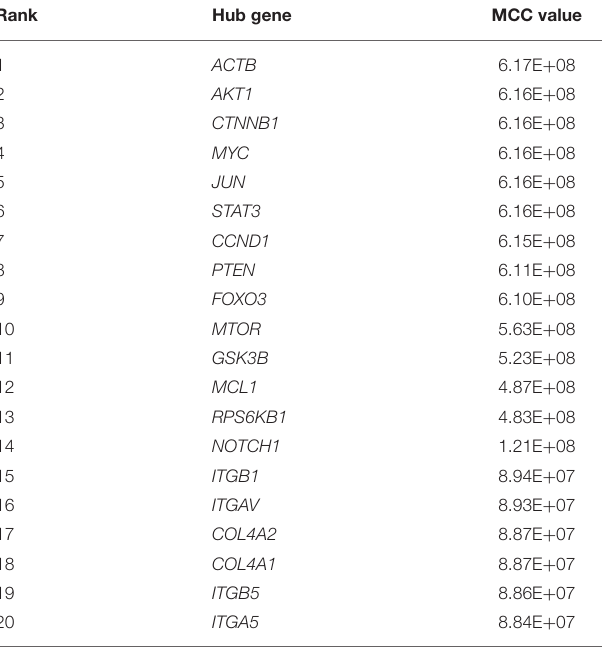
TABLE 4 | Hub Genes with the Top 20 MCC values in the PPI network. TABLE 5 | Hub genes with the Top 20 degrees in the PPI